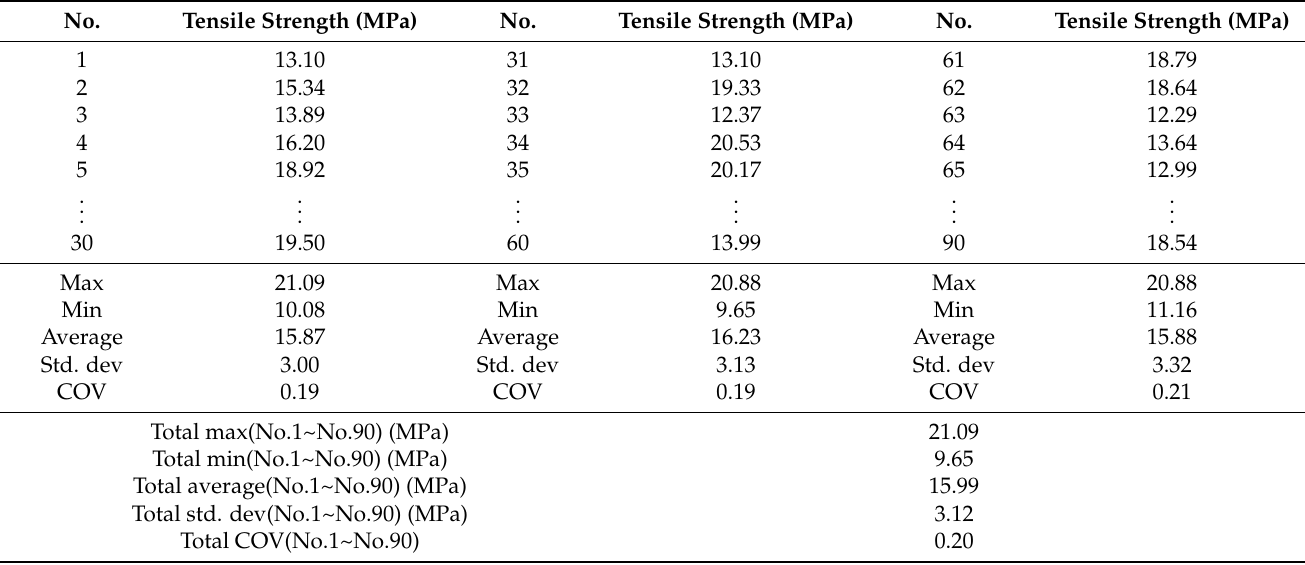
Table 4. Results of tensile tests for Case 2.